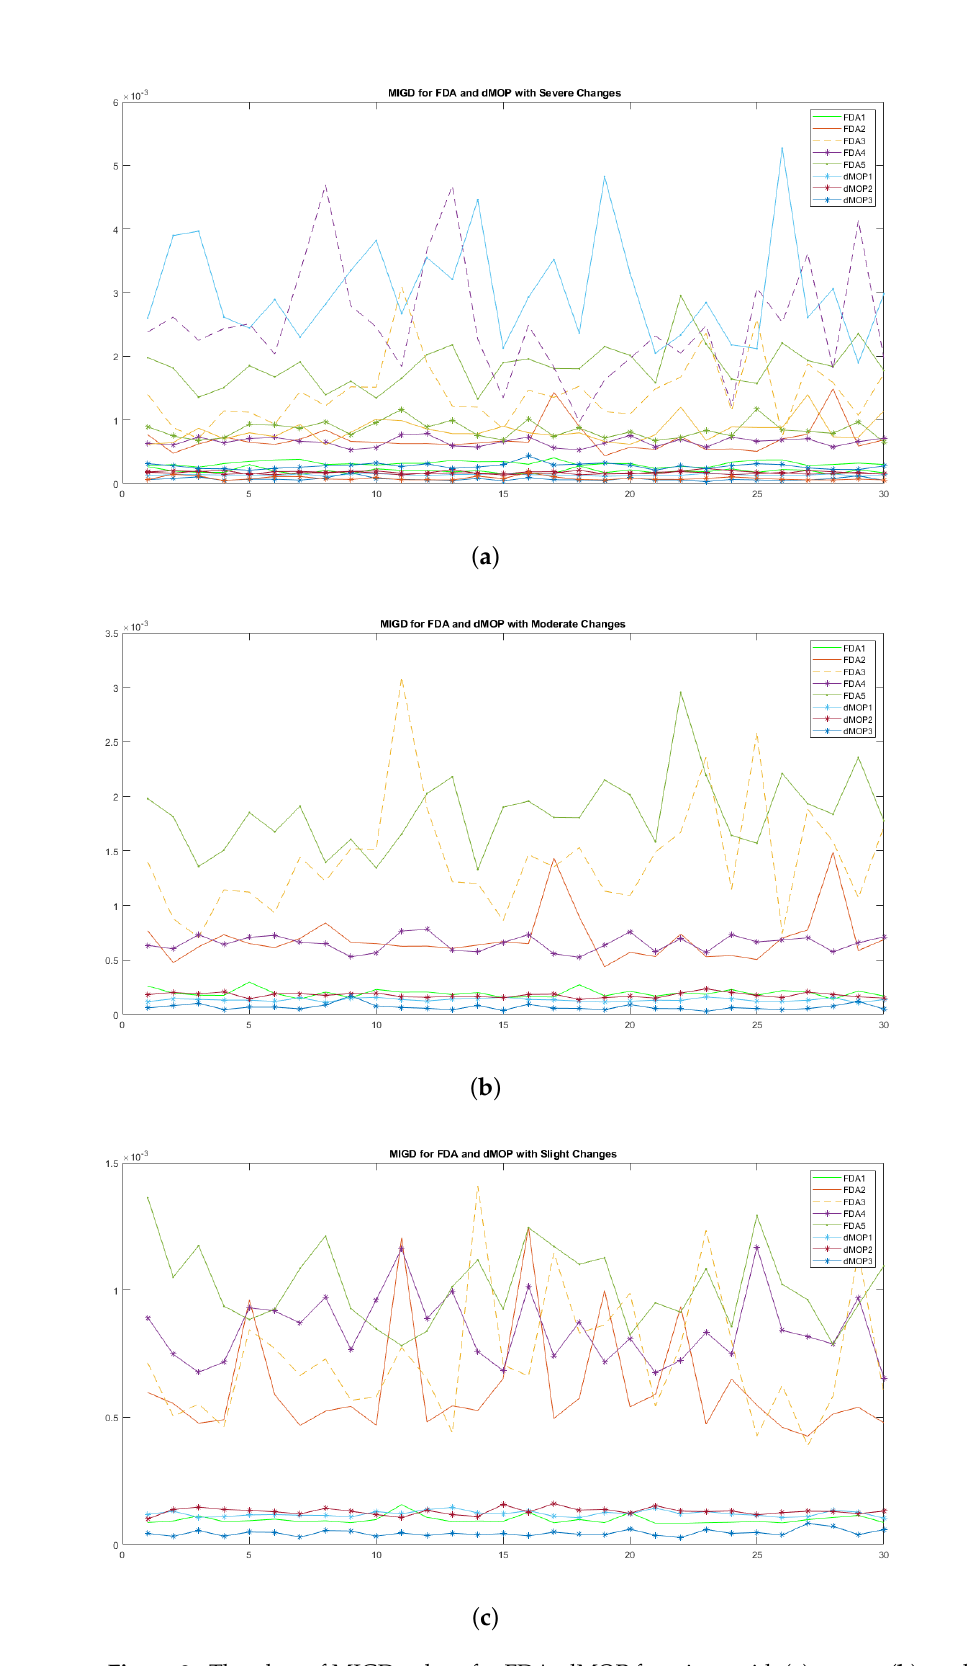
Figure 9. The plots of MIGD values for FDA, dMOP functions with ( a ) severe, ( b ) moderate and ( c ) slight environmental changes using the DB-CSA